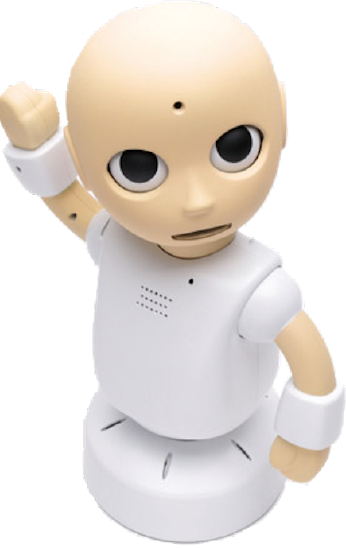
Figure 1. Small humanoid robot,